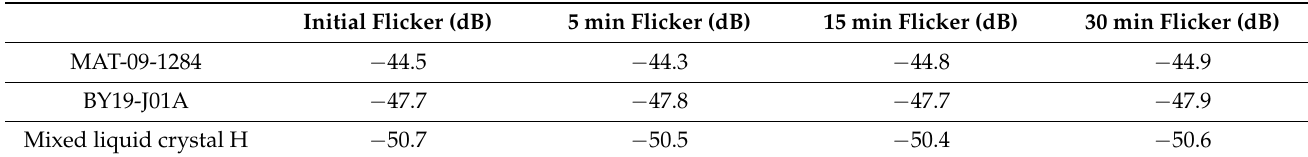
Table 6. The flicker of mixed liquid crystal